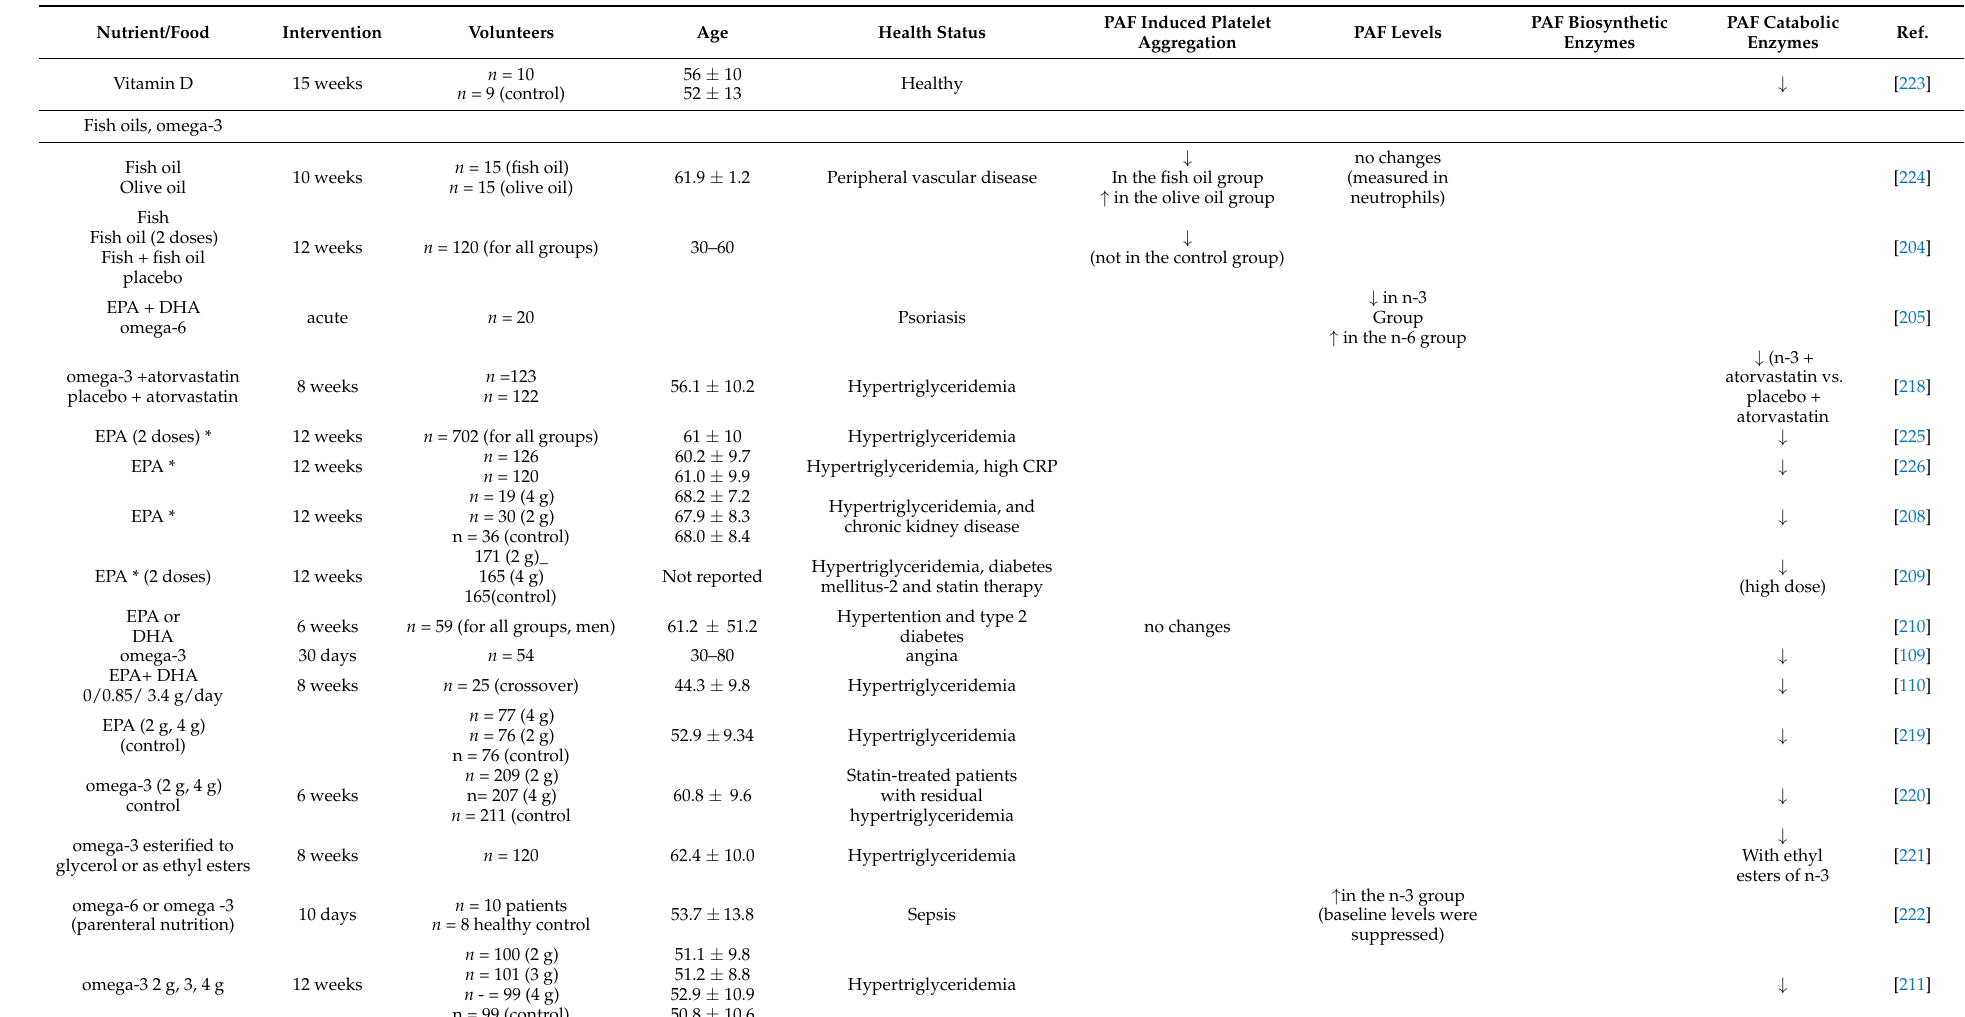
Table 1. Human clinical trials regarding the effects of foods/nutrients on PAF and its